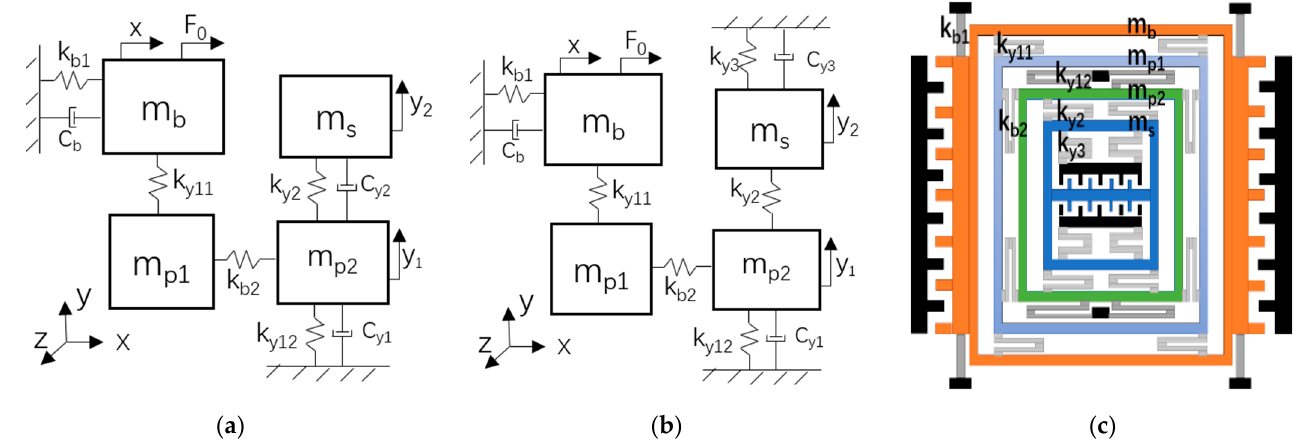
Figure 1. Fully decoupled 3-DoF micro-gyroscope: ( a ) Incomplete 2-DoF sense mode system; ( b ) Com- plete 2-DoF sense mode system; ( c ) Physical schematic diagram of the